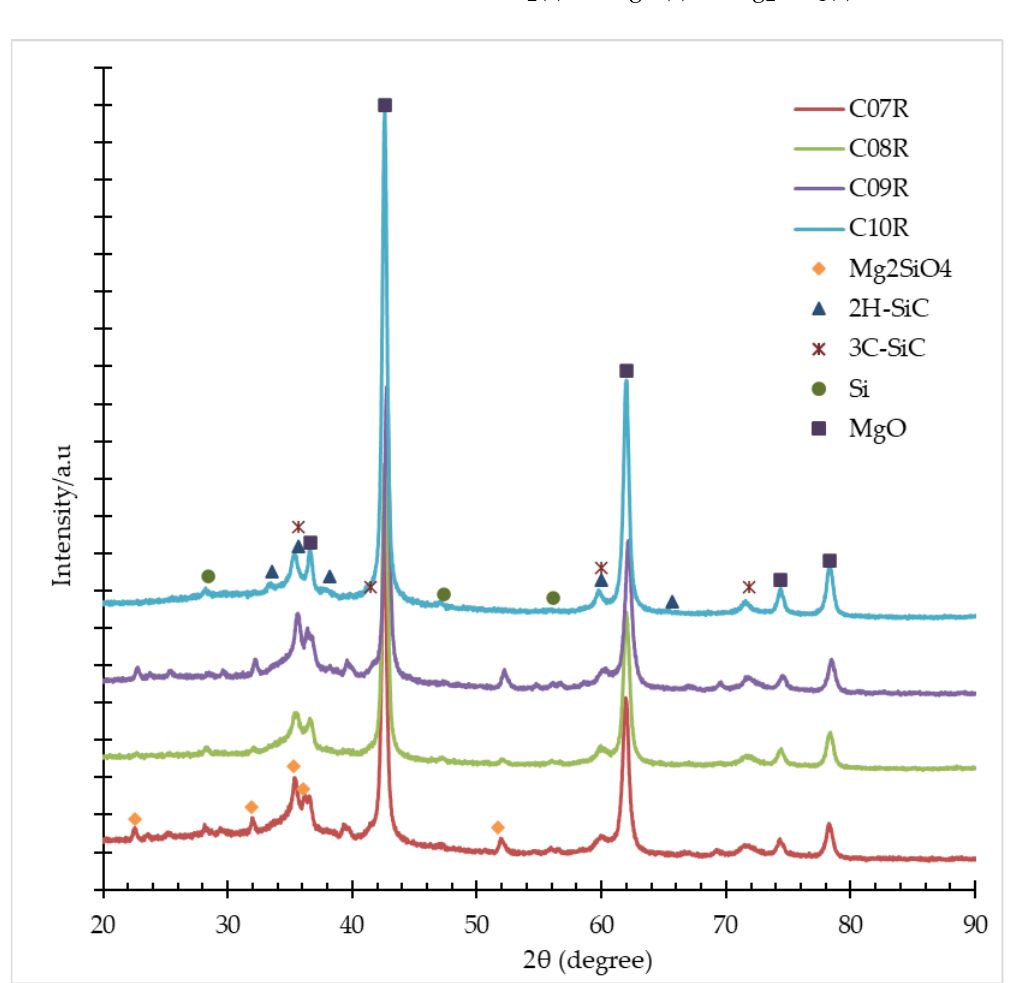
Figure 3. Diffraction pattern of reduction products from rice husk char base with various treatments.